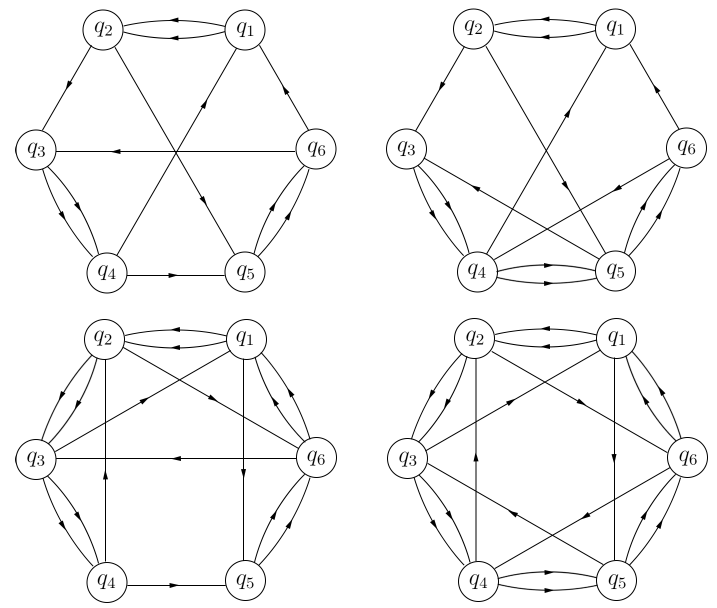
Figure 12 . The quiver diagram for 5d SU(3) k theories for k = 0 , 1 , 2 , 3 (top-left, top-right, bottom- left and